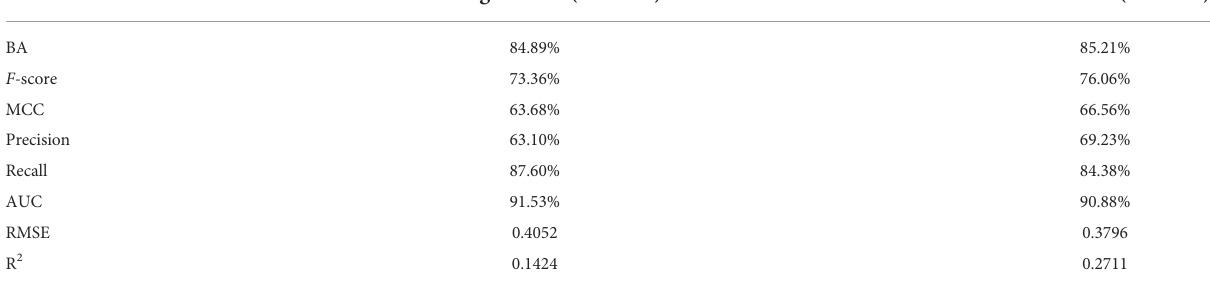
TABLE 2 Performance of the XGBoost model.